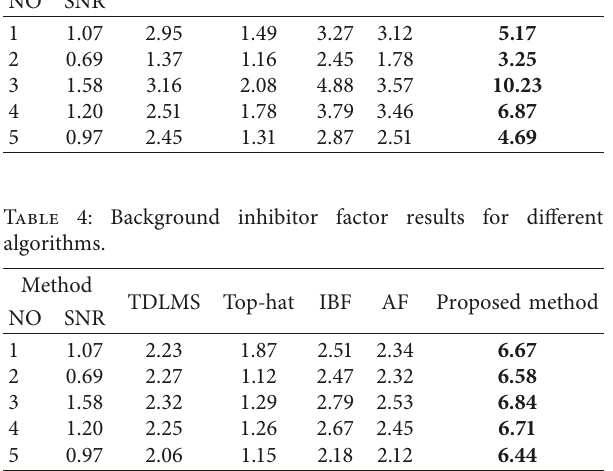
Table 3: SNR gain results of different algorithms. Method